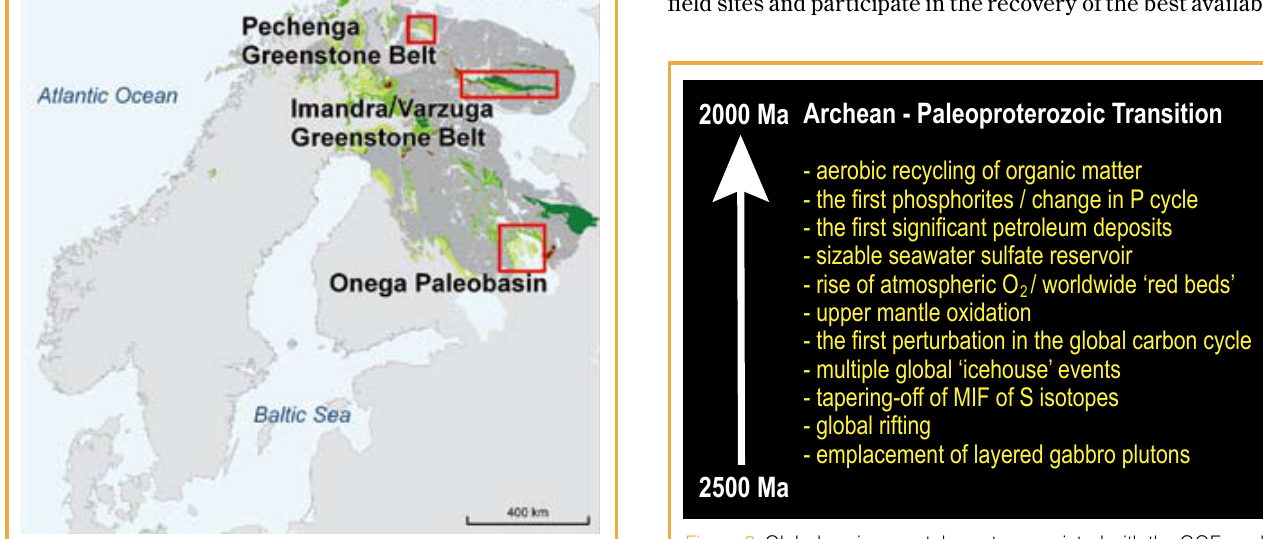
Figure 1. Geographic locations of the FAR-DEEP drilling operations.